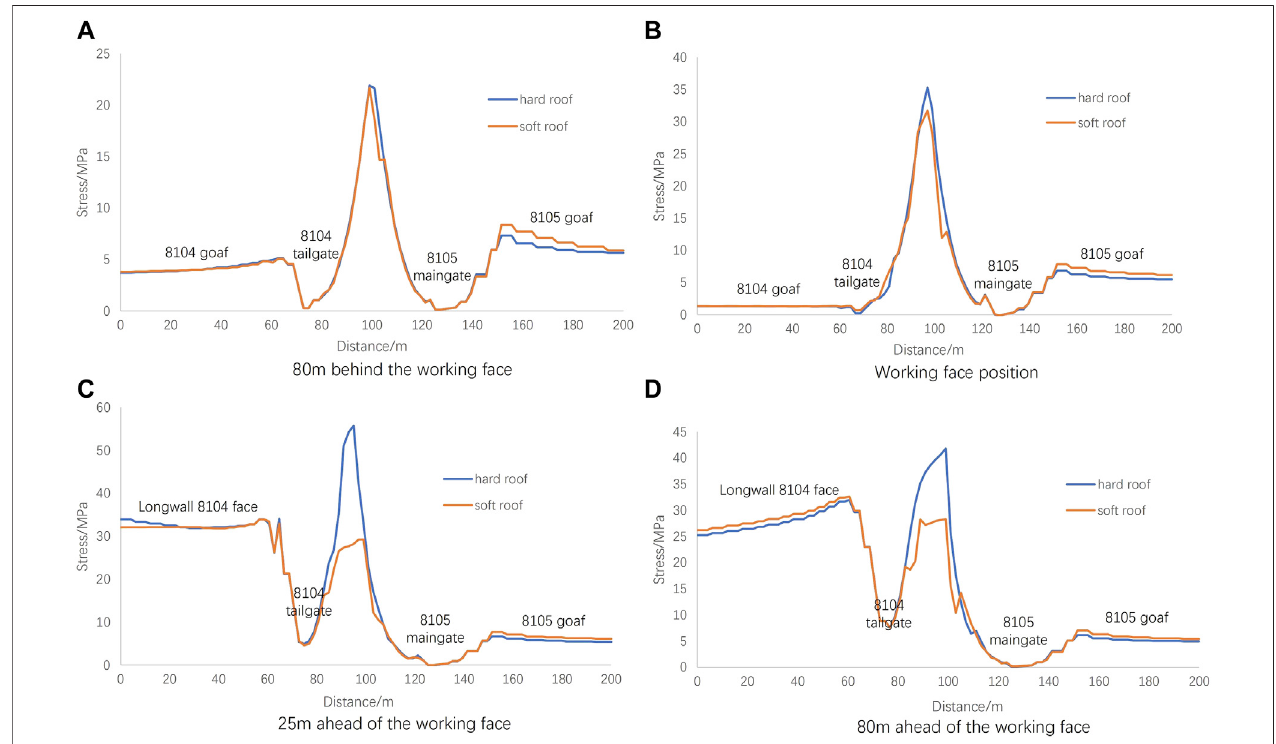
FIGURE 10 | Vertical stress distribution curve of the coal pillar at different positions.